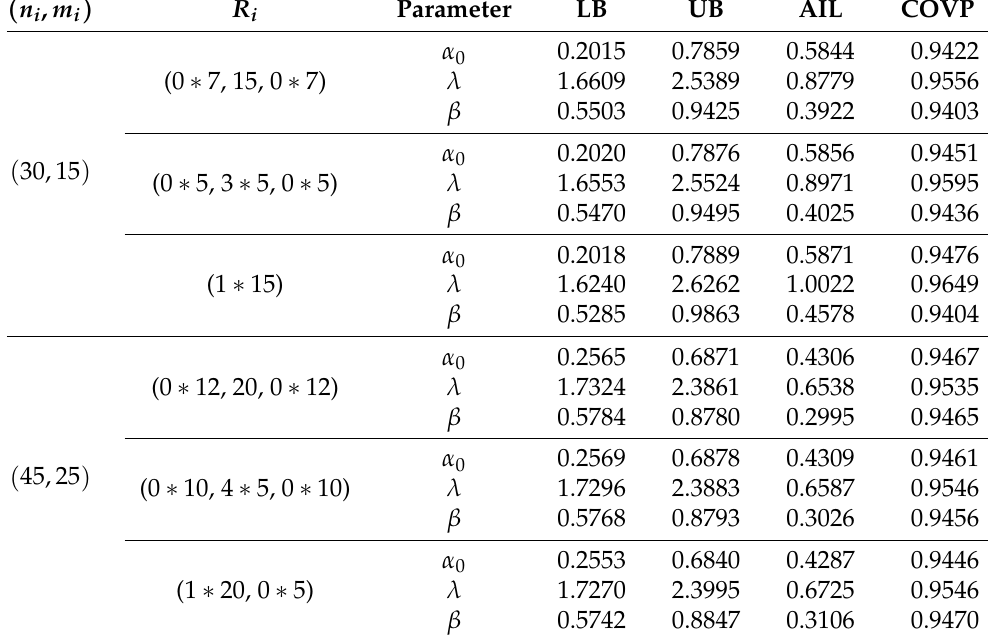
Table 4. The lower bounds (LB), upper bounds (UB), average interval lengths (AIL) and coverage probabilities (COVP) of the 95% asymptotic confidence intervals for different sample sizes ( n i , m i ) and different censoring schemes R i